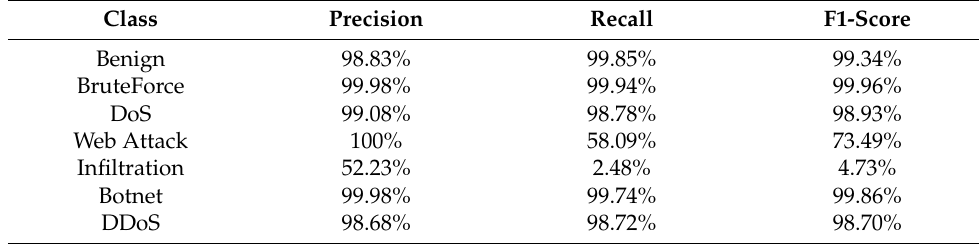
Table 22. CNN evaluation results for multi-class classification.